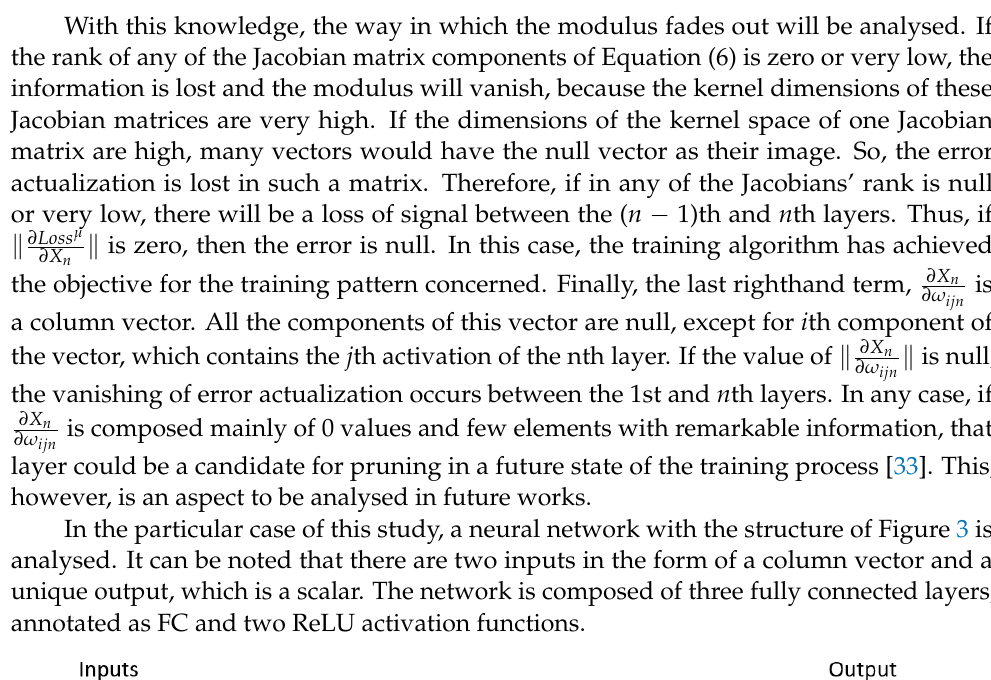
Figure 2. General representation of the size of the components of the equation.